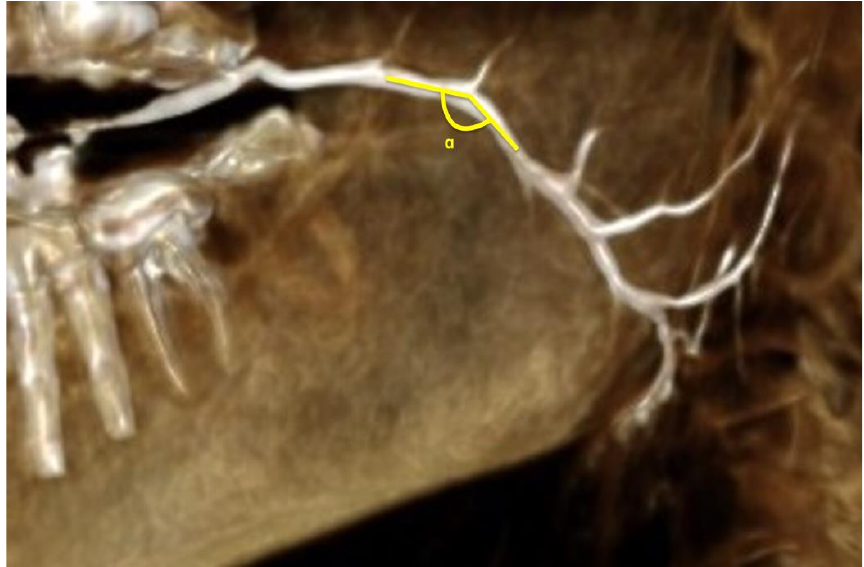
Figure 4. Angle of curvature of parotid duct ( α ).